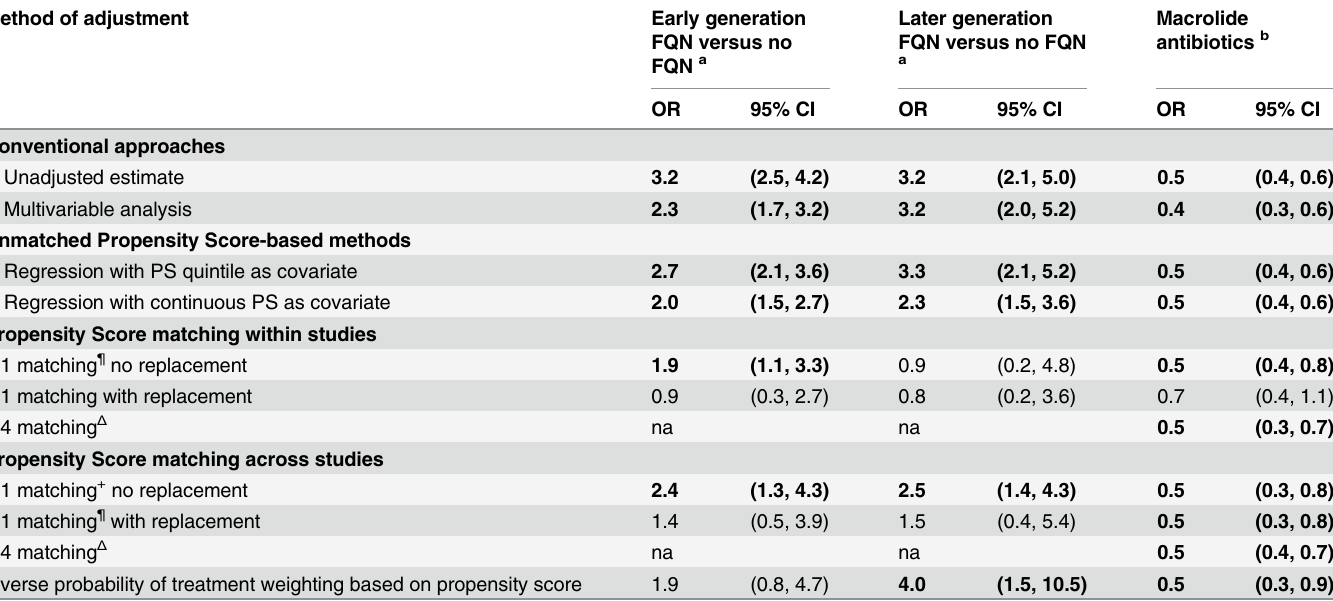
Table 7. The relationship between antibiotic use and successful treatment of tuberculosis (versus death, relapse or failure), applying different ana- lytic methods to account for